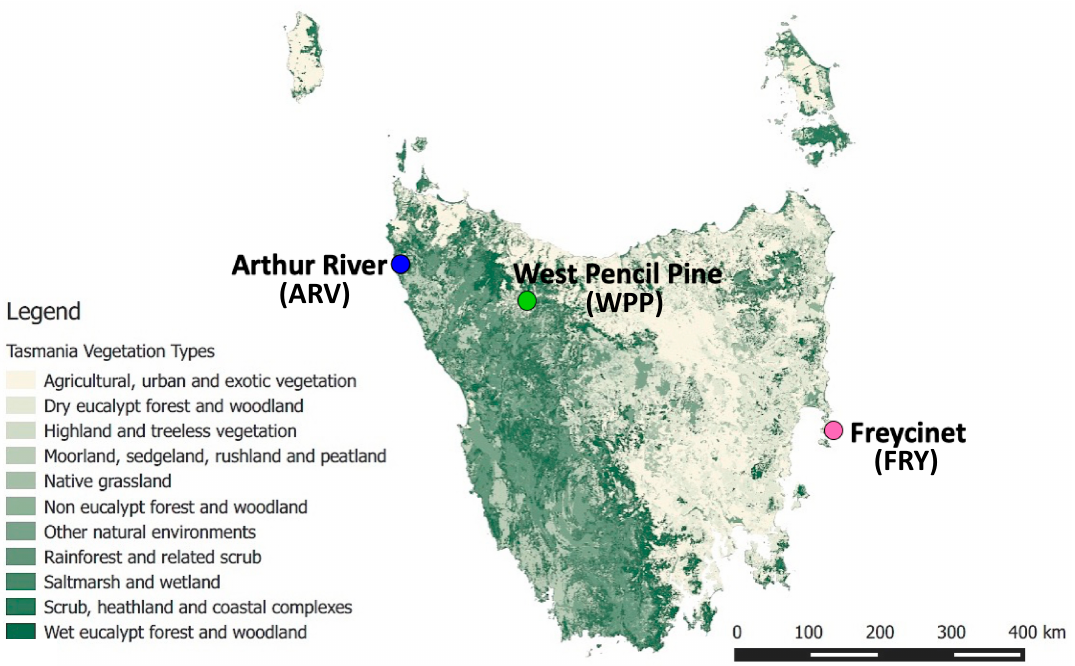
Figure 1. Map of our three geographic sampling locations across Tasmania showing the vegetation distribution across Tasmania.